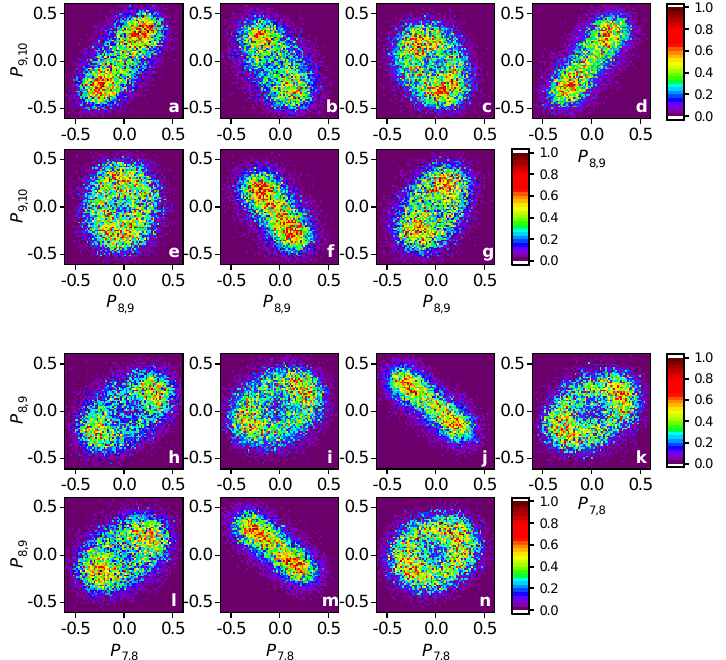
Figure 5. Experimental correlation plots for a phase scan using PS 2 in the four-harmonic case. ( a – g ) Evolution of the correlation plots of the oscillating components of the sidebands ( P 8,9 , P 9,10 ) for increasing values of the delay τ s 2 introduced by the phase shifter PS 2 . ( h – n ) Evolution of the correlation plots of the oscillating components of the sidebands ( P 7,8 , P 8,9 ) for increasing values of the delay τ s 2 introduced by the phase shifter PS 2 . The color scale indicates the density of single-shot experimental points normalized to unity for each